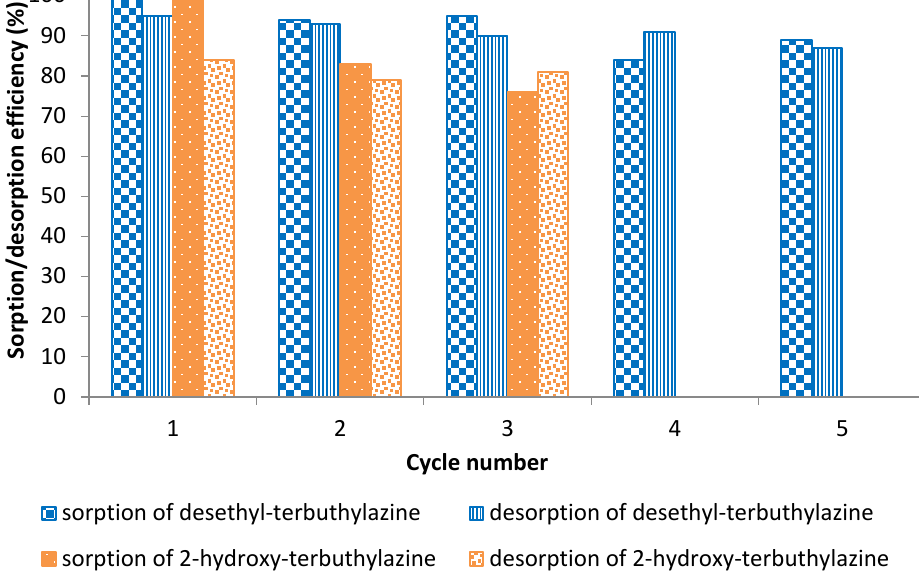
Figure 11. Efficiency of sorption and desorption of studied terbuthylazine metabolites.